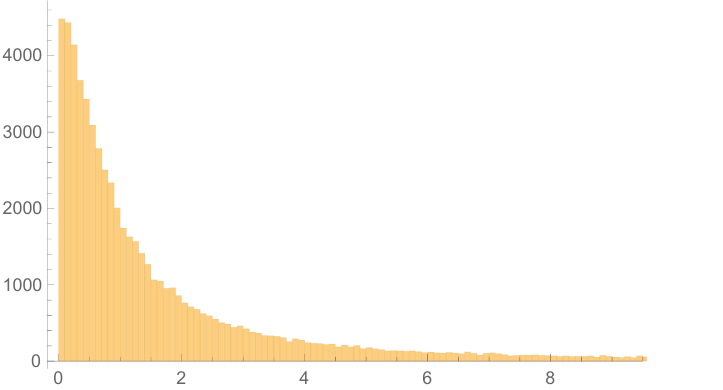
Figure 12 . The ratio of the distances between nearest eigenvalues for the SYK spectrum given in (cid:12)gure